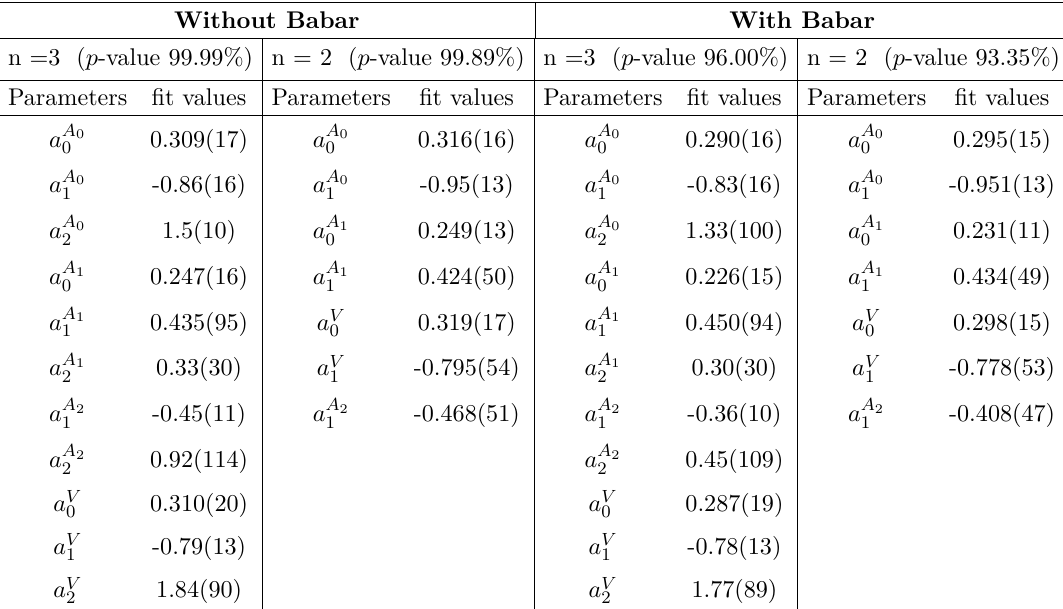
for the vector ( V ), axial-vector n ’s do not take part in n